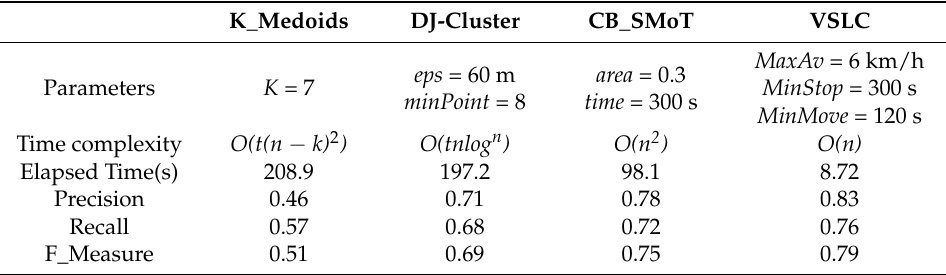
Table 2. Results of different stop extraction algorithms for Dataset 1.